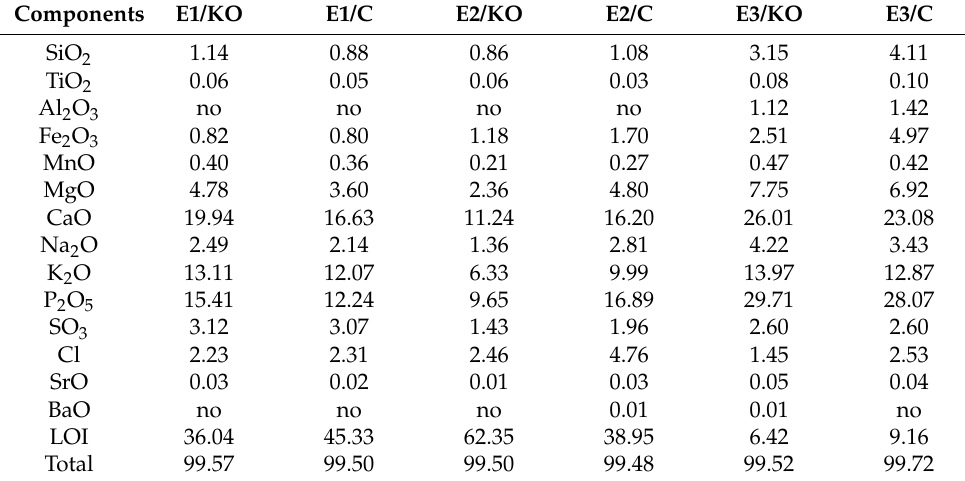
Table 5. Chemical composition (% wt.) of ashes obtained from combustion of poultry manure in three experiments E1, E3 and E3. Components